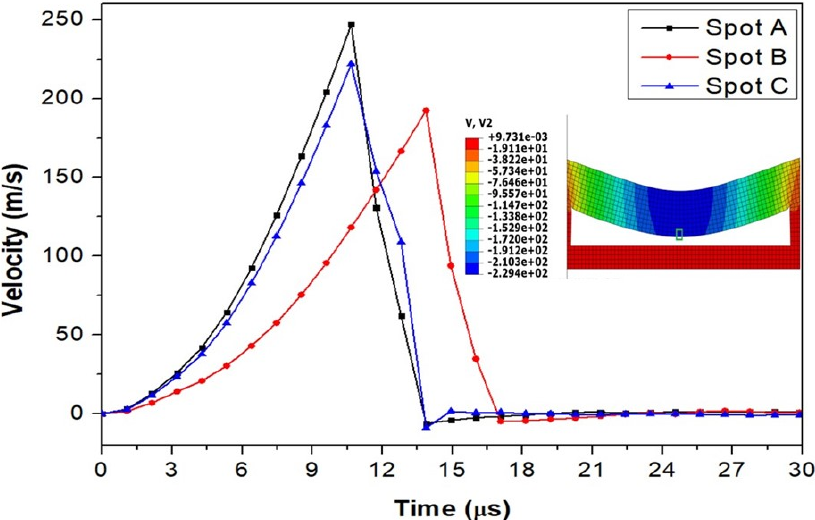
Figure 21. Impact velocity at three spots. Window image shows the variations for spot C.